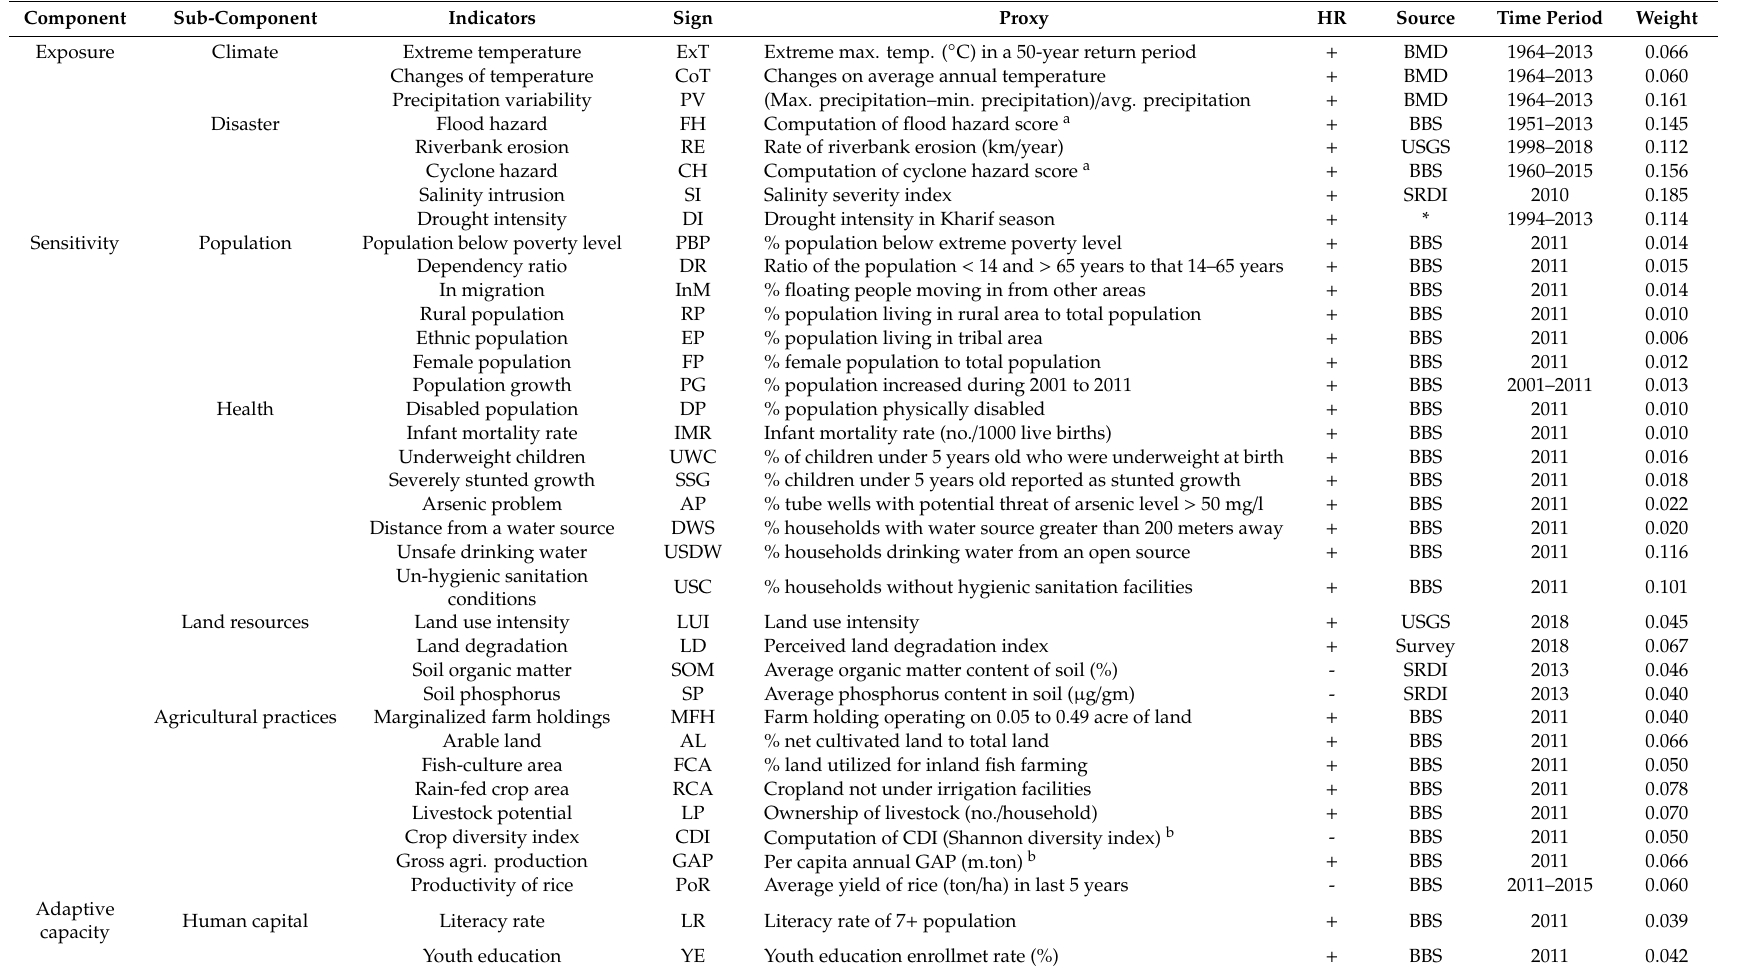
Table 1. Vulnerability components, sub-components, indicators and their functional relationships with major components and data sources, and final relative weight of